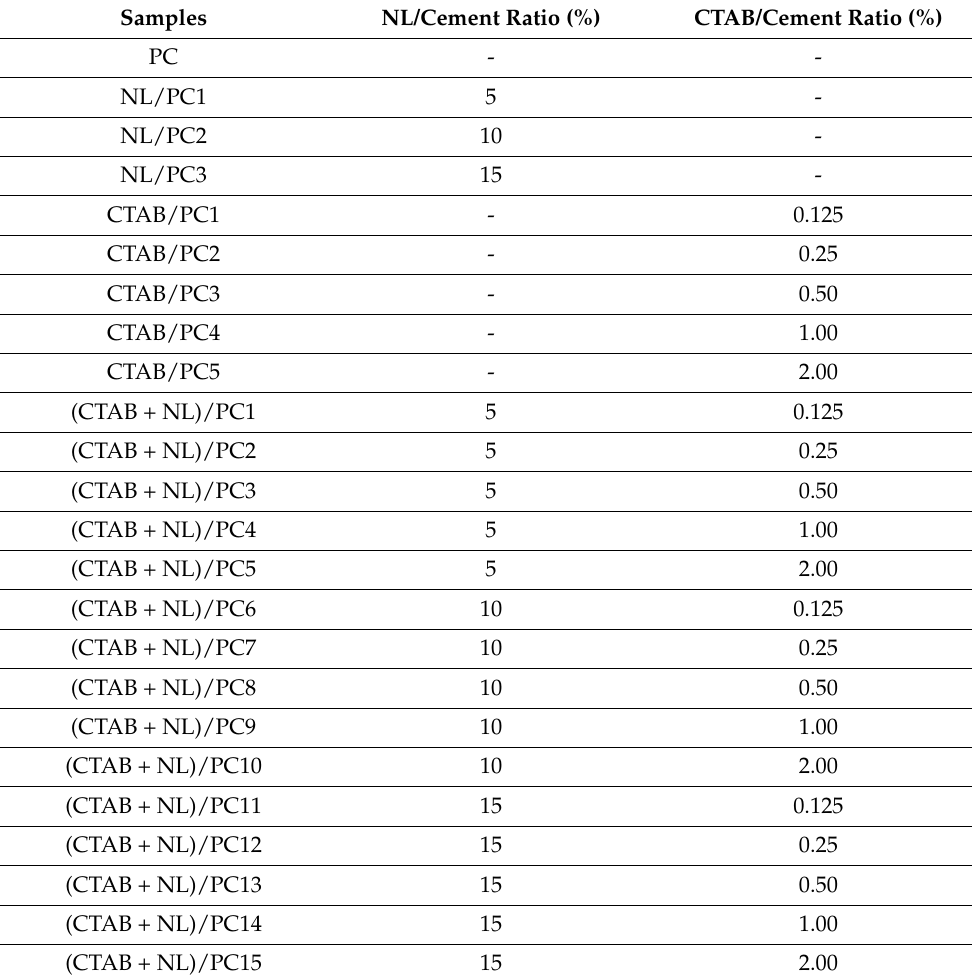
Table 2. Mixing ratios for cement pastes with a W/C ratio of